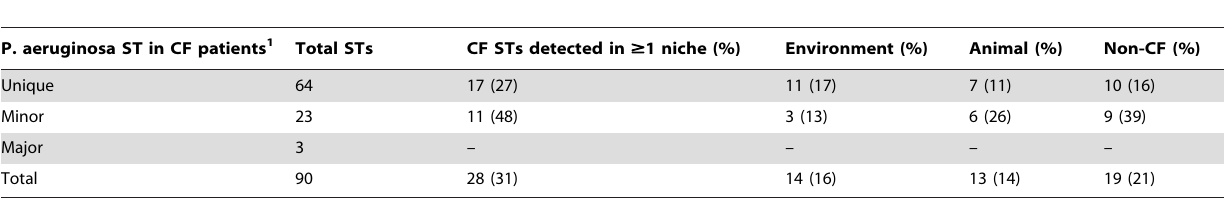
Table 4. Relationships between local cystic fibrosis (CF) Pseudomonas aeruginosa s equence types (STs) and identical STs detected in other ecological settings.